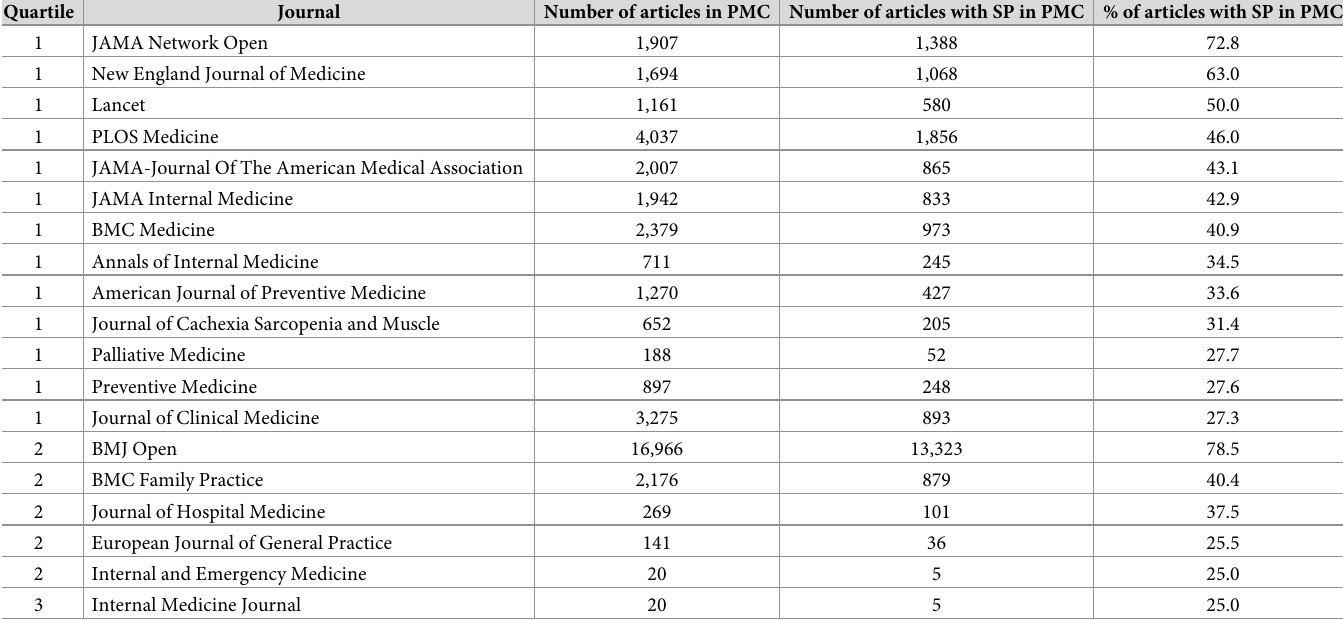
Table 2. Metrics and journals including a percentage of supplementary material (SP) greater than 25%. All journals analyzed belong to the “Medicine, General & Internal” category of the 2019 Science Citation Index Edition of the JCR (S1 Table).